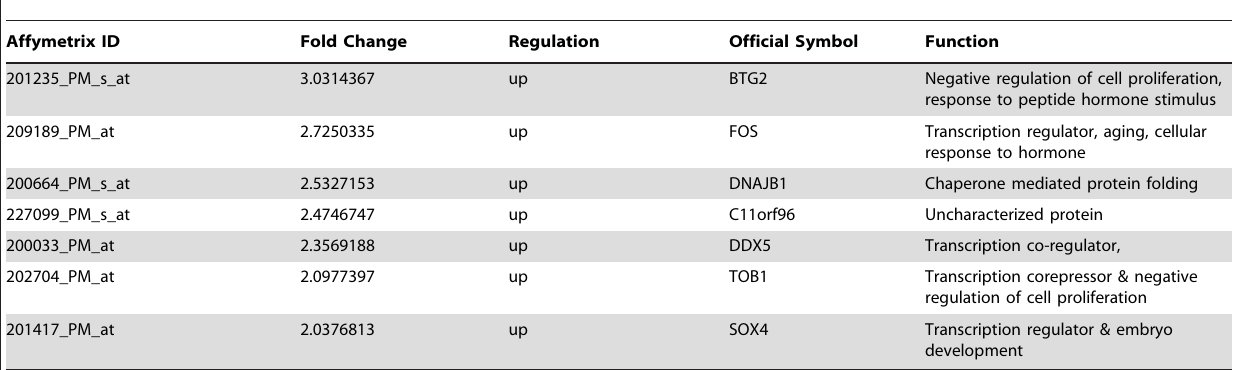
Table 2. Differentially expressed genes identified in old versus young elephant adipose